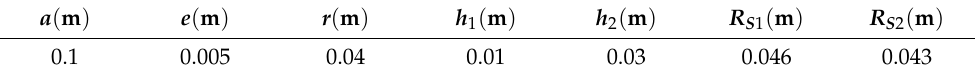
Table 2. Geometric parameters used in calculations in Figure 2.